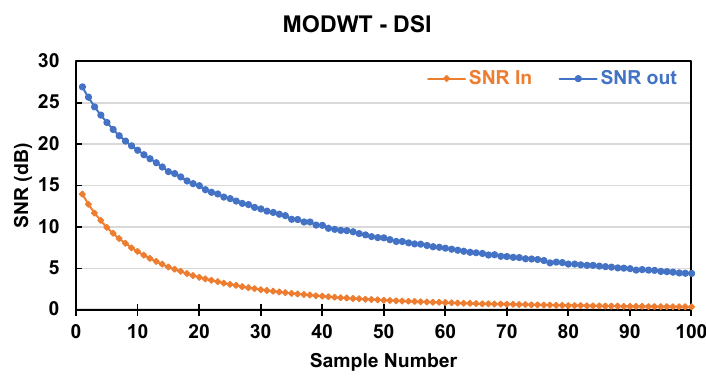
Figure 14. SNR of 100 samples of PD signals contaminated with DSI. The maximum ∆ SNR = 12.39 dB, the minimum = 4.04 dB, and the average = 7.89 dB.